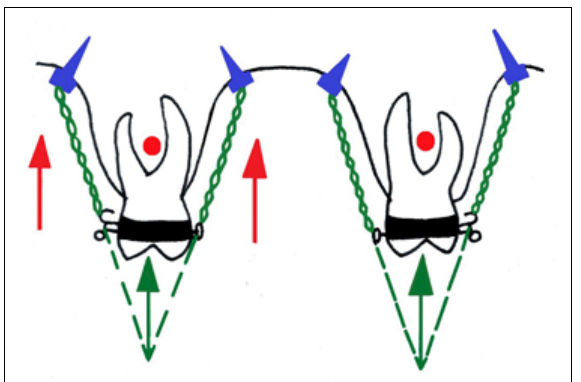
Figure 4. Force system produced by buccal and palatal miniscrews along the central axis of maxillary first molar for intrusion.